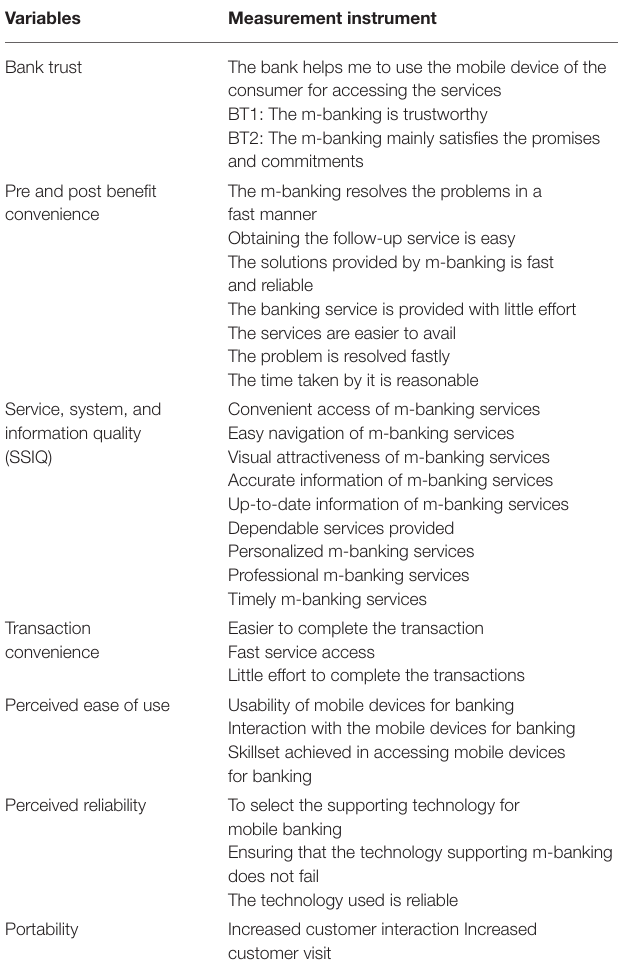
TABLE 3 | Measurement instrument to analyze different